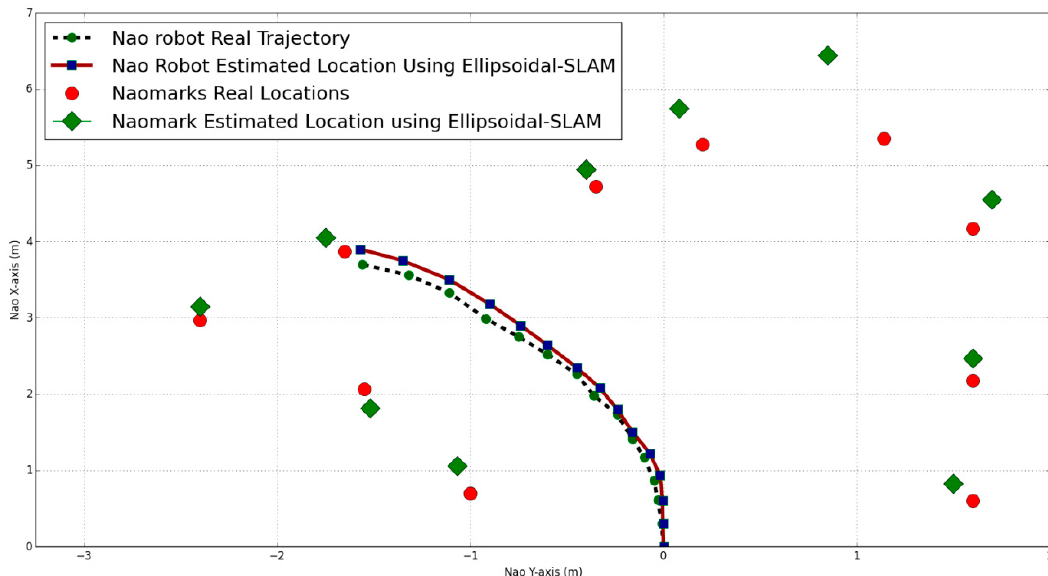
20 of 28 Figure 16. NAO location and NAO markers positions with real-time implementation of EKF SLAM. In practice, the NAO robot detected some falsely-positive NAO markers. The false positive problem happened firstly because of illumination, as mentioned previously, and because of the NAO camera’s field of view; the NAO detects only one NAO marker at once so if two NAO markers